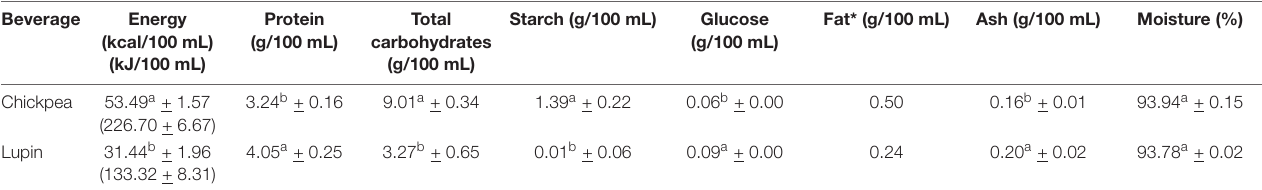
Values are represented as mean ± standard deviation (SD) (n = 3). Distinct letters in samples per parameter, evidence significant differences among them (p < 0.05). *Calculation as explained in section “Physico-Chemical Analysis”.